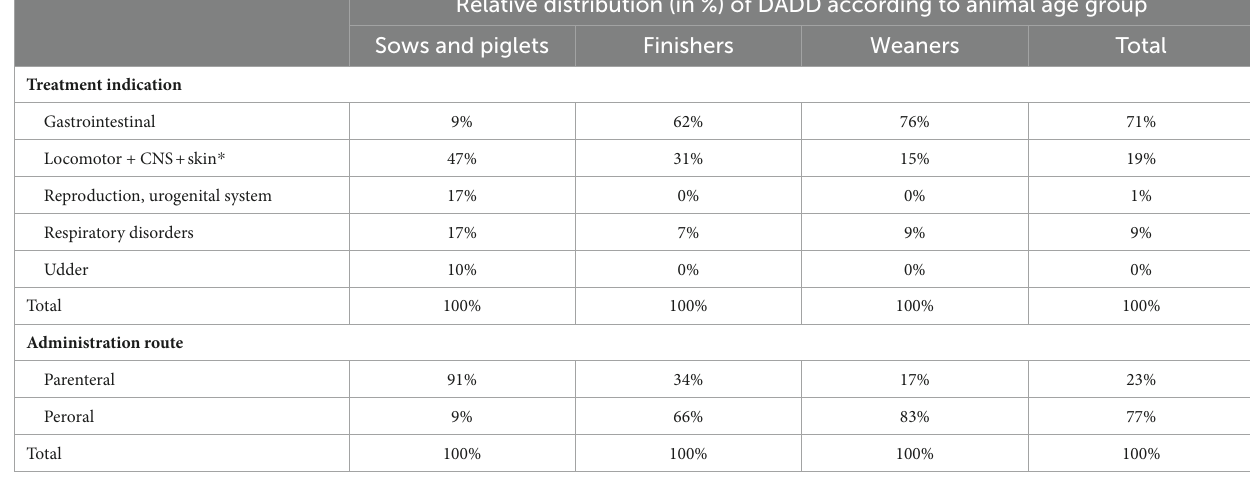
TABLE 2 AM treatments shown as % of DADD units used by the Danish pig sector in 2020, divided according to age category, treatment indication and administration route. Relative distribution (in %) of DADD according to animal age group Sows and piglets